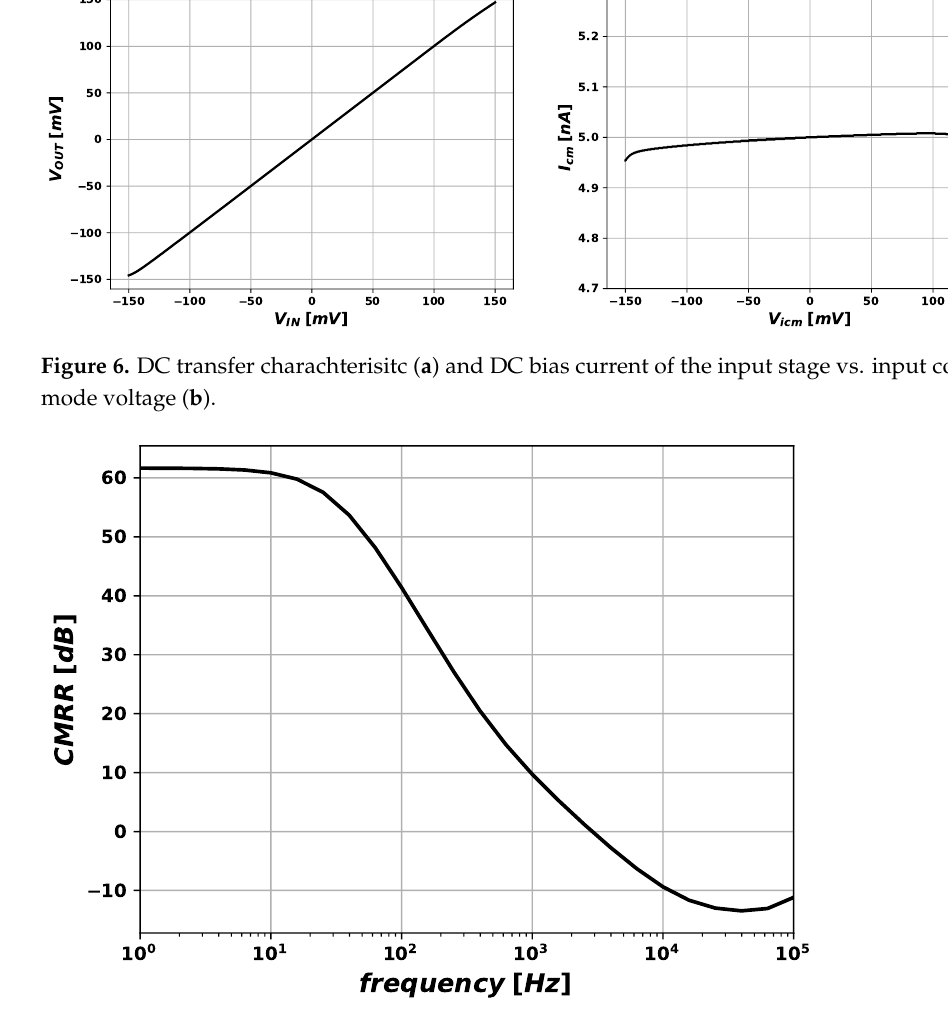
Figure 7. Magnitude of common mode rejection ratio